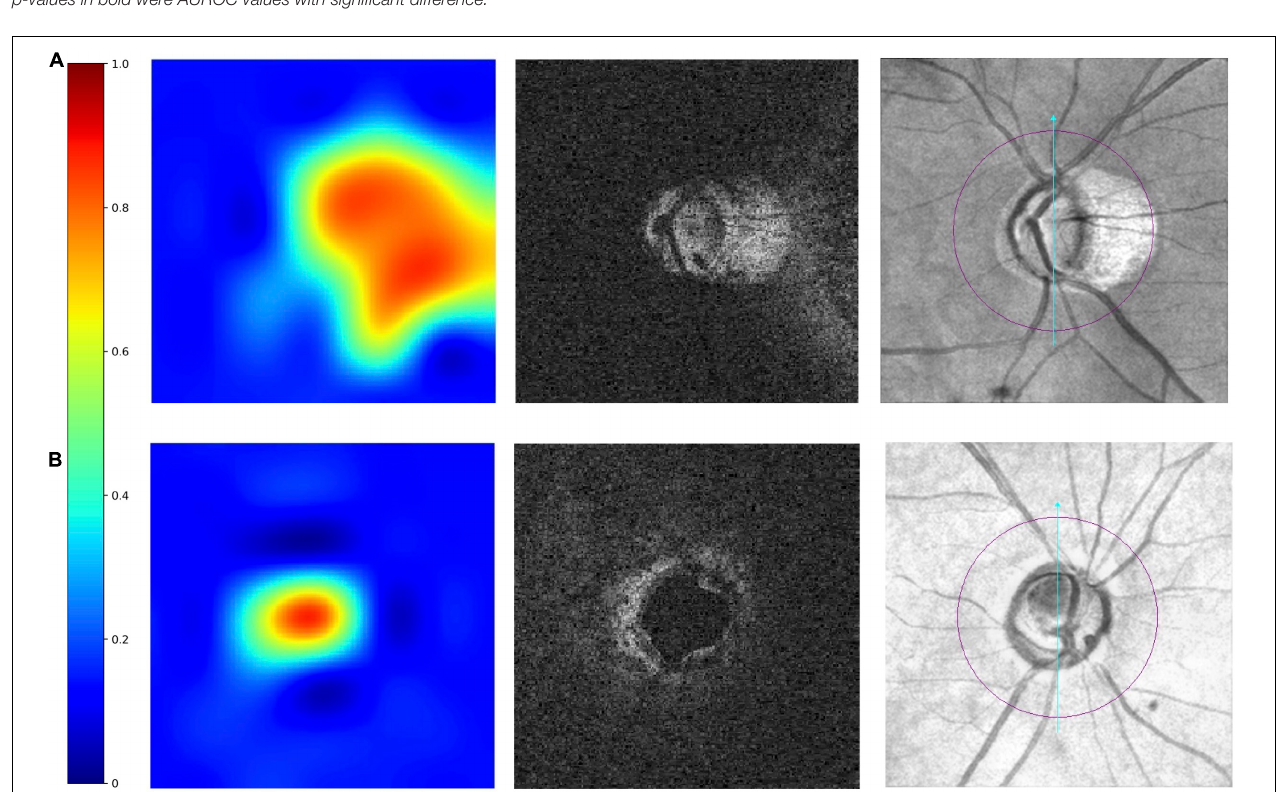
FIGURE 3 | Examples of truly detected eyes by the multi-task 3D DL model. From left to right were heatmaps, raw images, and the corresponding en face fundus images. The red–orange-coloured area on heatmaps has the most discriminatory power to detect MF. The heatmaps shows in panel (A) an eye with myopic features (peripapillary atrophy, PPA), the optic disc area and the areas with PPA is red-orange-coloured. In panel (B) an eye without myopic features, only optic disc was red-orange-coloured.